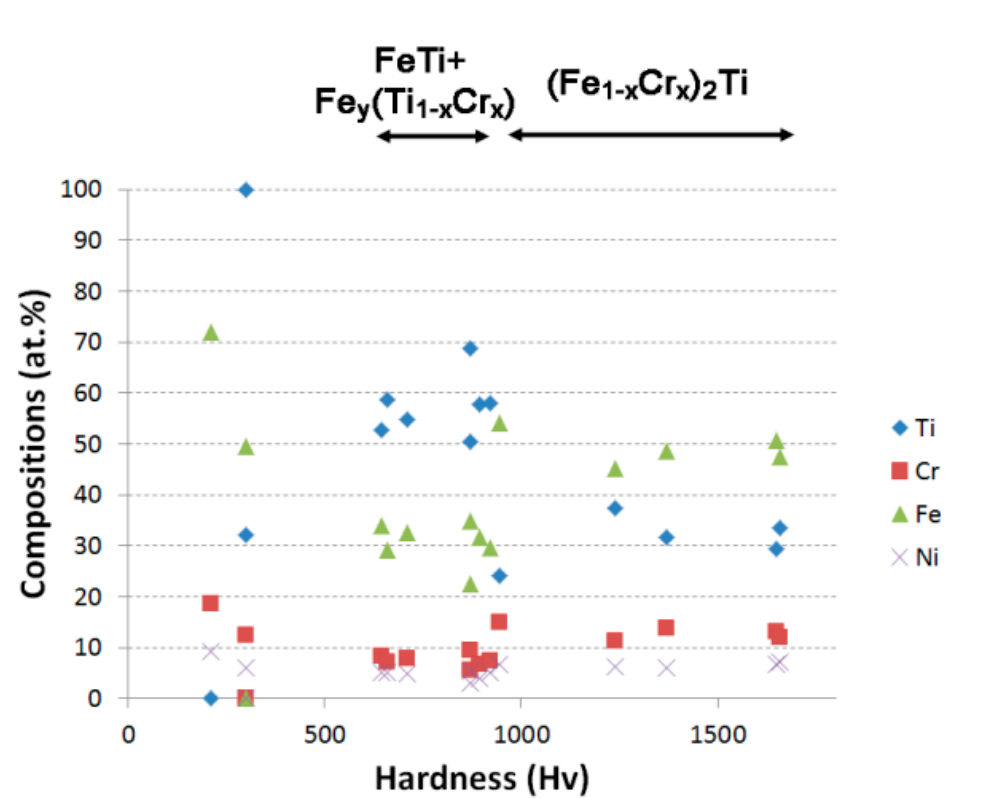
Figure 7. Variation of hardness with composition for the LBW sample.